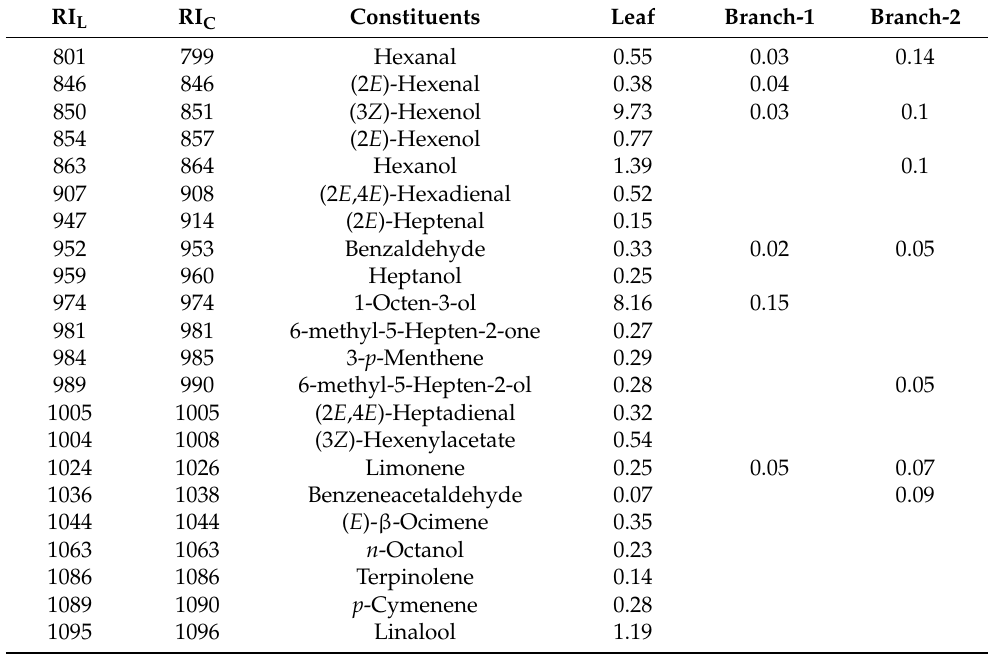
Table 1. Constituents (%) identified in the essential oils of the leaf, primary and secondary branches of Miconia minutiflora .